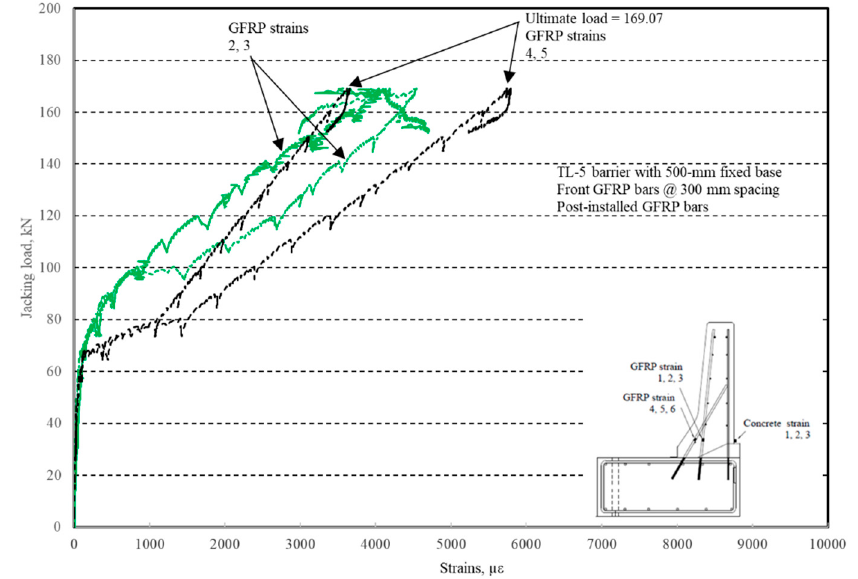
Materials 2019 , 12 , x FOR PEER REVIEW Figure 28. Specimen # 5: Load vs. GFRP bar strain history. Figure 28. Specimen # 5: Load vs. GFRP bar strain history.